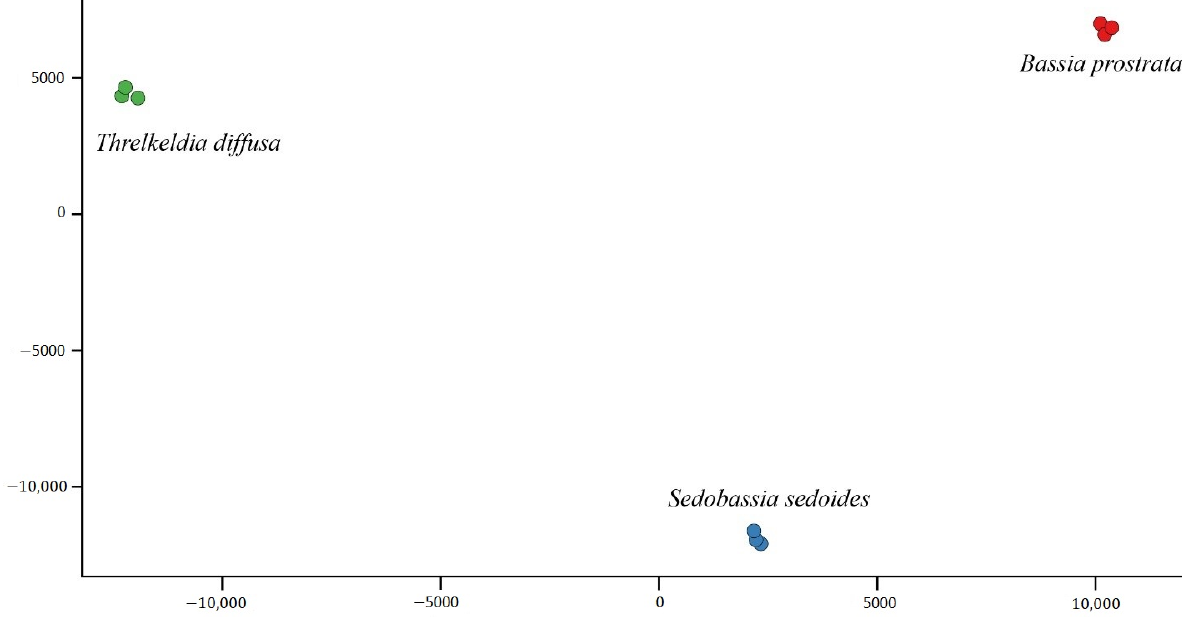
Figure 1. Principal component analysis of log 2 -transformed reads. The first ( x -axis) and the second ( y -axis) components are shown, which explain 51.47% and 42.51% of the total variation, respectively.